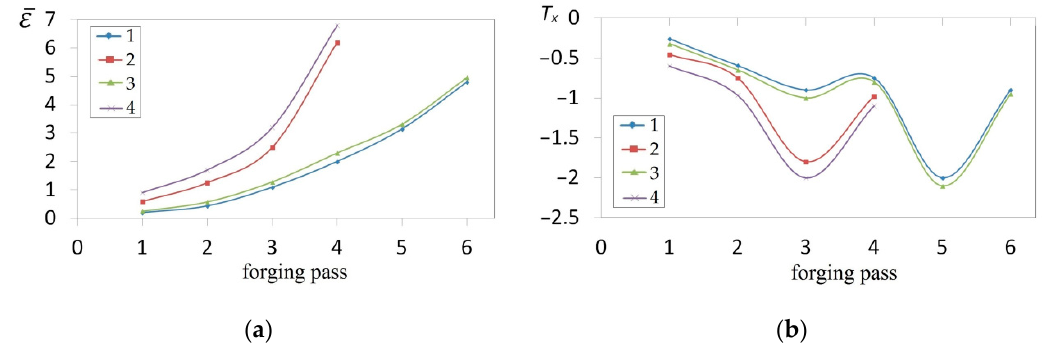
Figure 18. Influence of different passes upon the effective strain ε ( a ) and the stress triaxiality ratio T x ( b ) in the axial zone in the course of the cogging in V-shaped anvils of the forging with a concave cross-section for different angles and reduction ratio: 1— ε c = 0.22, α c = 135°; 2— ε c = 0.51, α c = 135°; 3— ε c = 0.22, α c = 165°; 4— ε c = 0.51, α c = 165°.